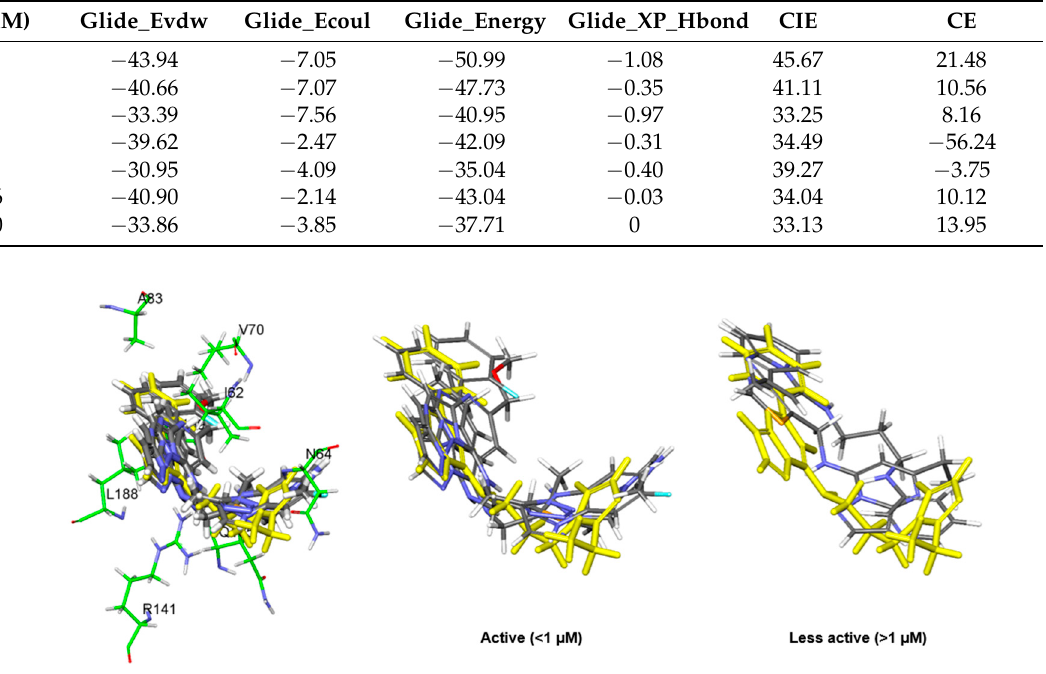
Figure 5. Molecular docking results of hit derivatives. The middle and right panels show overlapped structure of five active molecules which have an IC 50 less than 1 µ M and two less active molecules over than 1 µ M, respectively. Hit compound, cpd1, is displayed as a yellow stick model. Table 2. Binding energy scores of Glide, negative CDOCKER energy (CE), negative CDOCKER in- teraction energy (CIE) obtained from molecular docking simulations for hit derivatives.